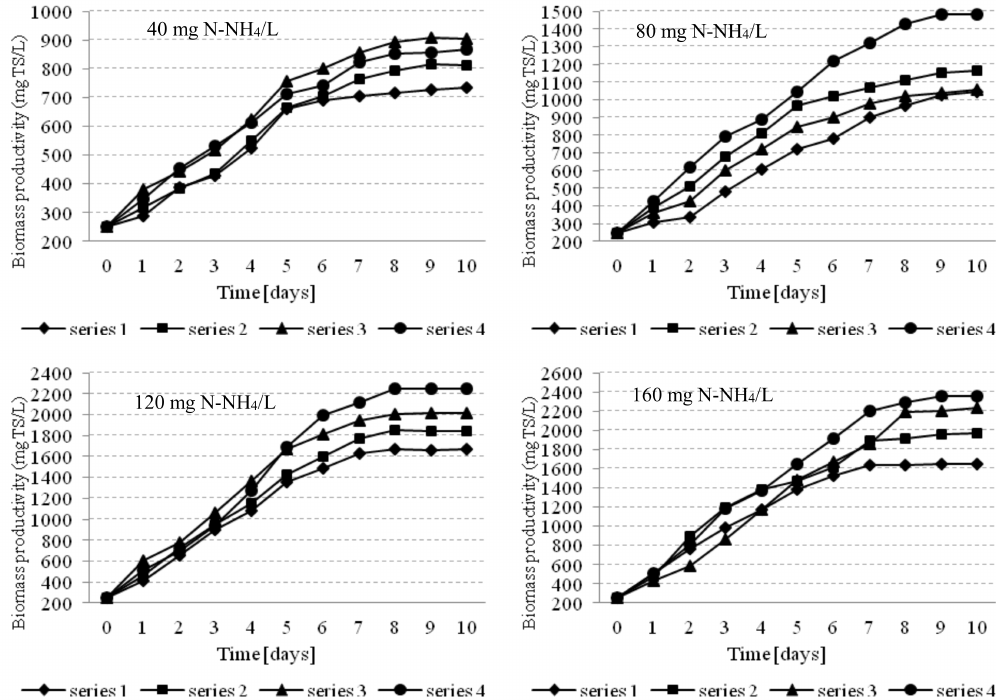
Figure 1. Scenedesmus sp. biomass productivity in experimental variants during the experimental